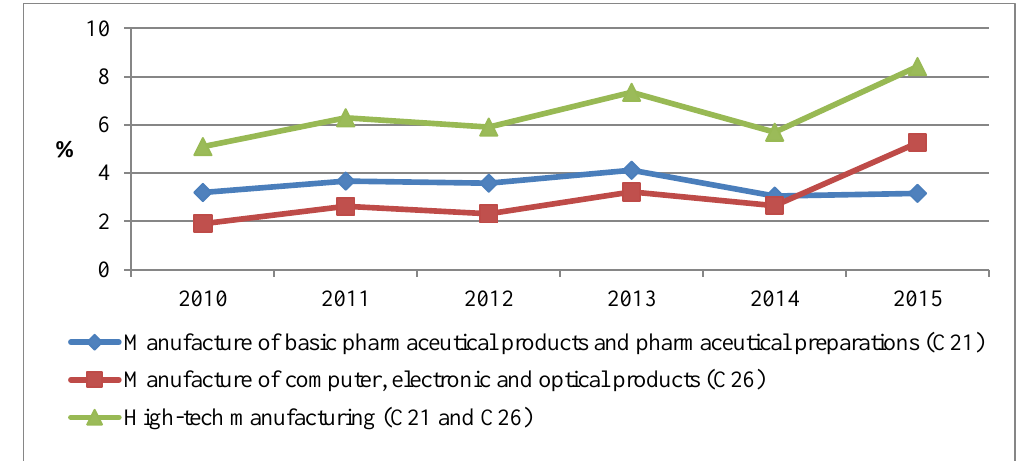
Fig. 1. The share of high-tech industries in the value added of manufacturing, %.